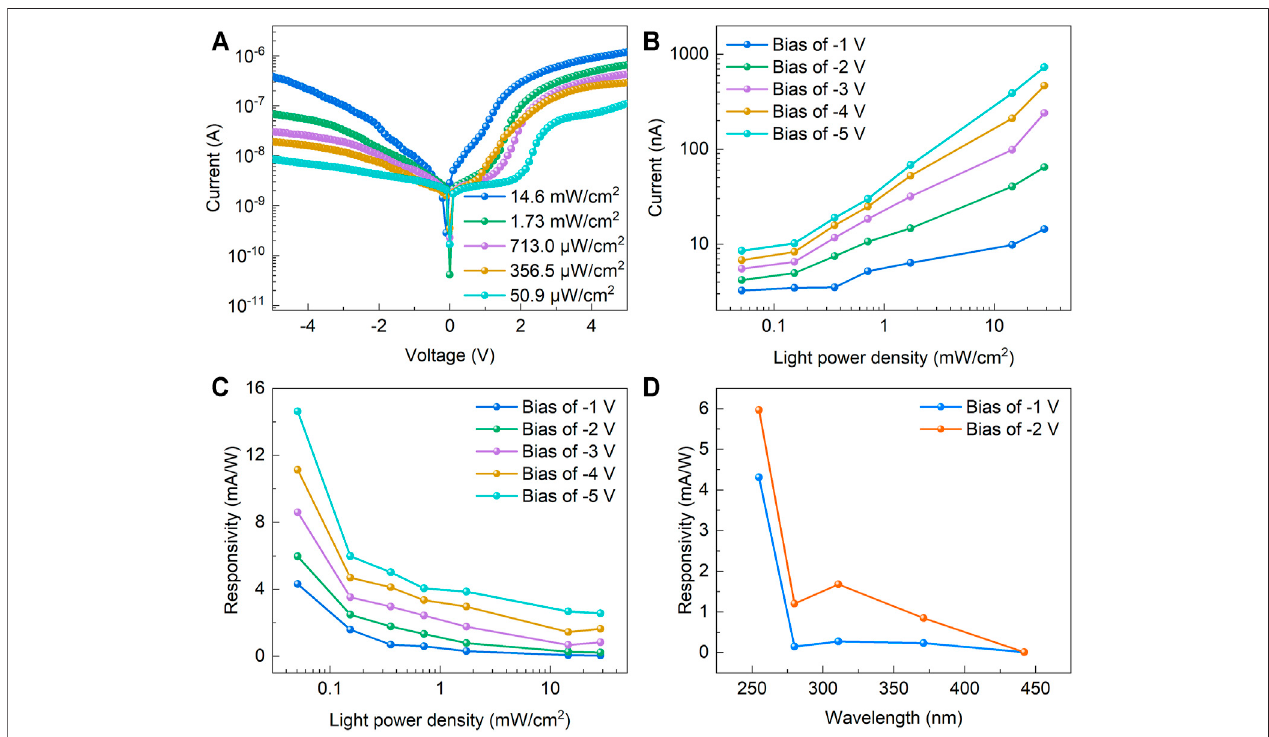
FIGURE4|(A) TheI-Vcharacteristiccurveofthedeviceunder255 nmwavelengthilluminationwithdissimilarcurrentdensities,theresultsindicatedthatunderthe samebiasvoltage,astheilluminationdensityincreases,thephotoresponsecurrentofthedevicealsoincreases. (B) Thegraphofthecurrentchangewiththelightdensity under different bias voltages. The current increases as the light power density increases, forming a linear relationship. (C) The change of responsivity with light density. Due to the gradual saturation of carrier generation rate, the responsivity of the device decreases as light density increases. (D) Compared with the responsivity to the light of different wavelengths under − 1 V and − 2 V bias voltage, whence it followed that the responsivity at 255 nm is very high.